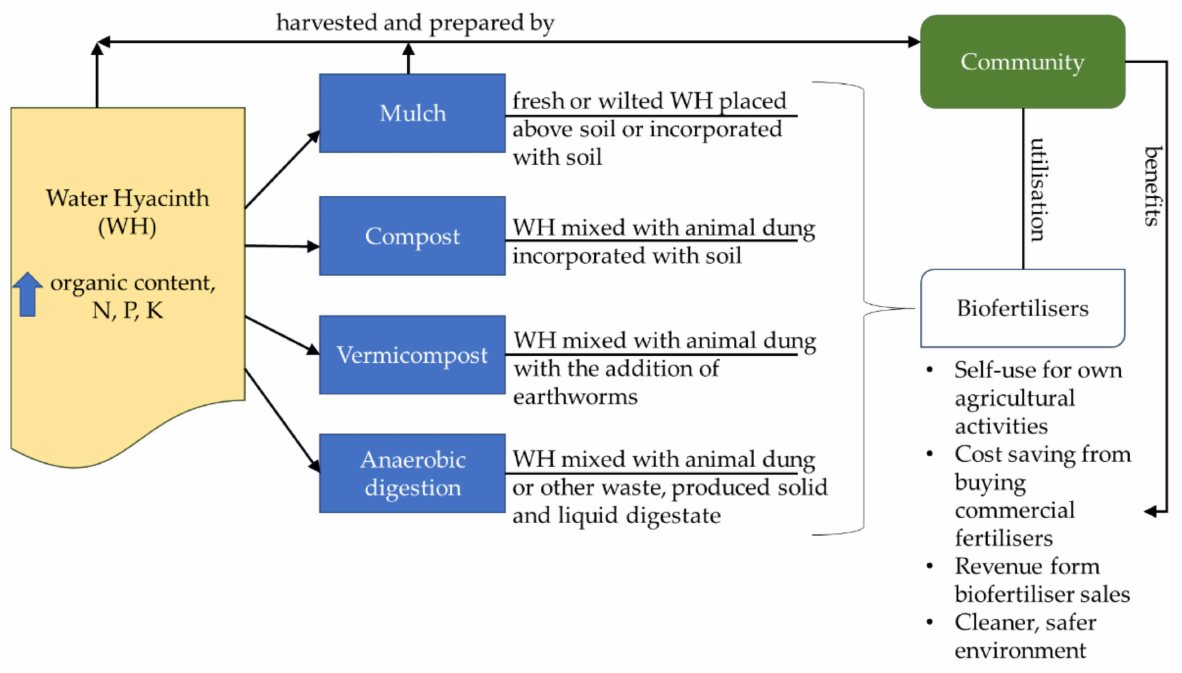
Figure 2. Water hyacinth valorisation to biofertilisers and the role and benefits of the